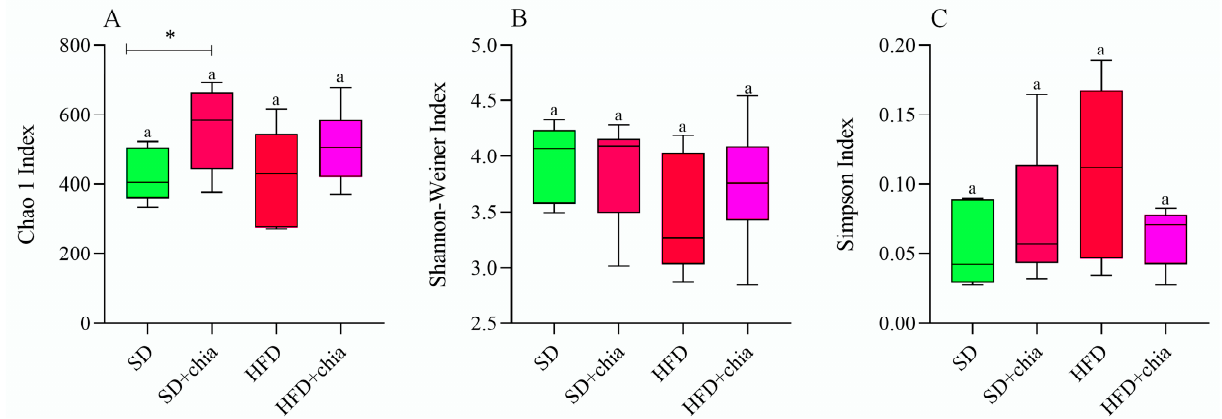
Figure 2 . Alpha diversity metrics of bacterial communities in the cecum faces. n = 6 per group. ( A